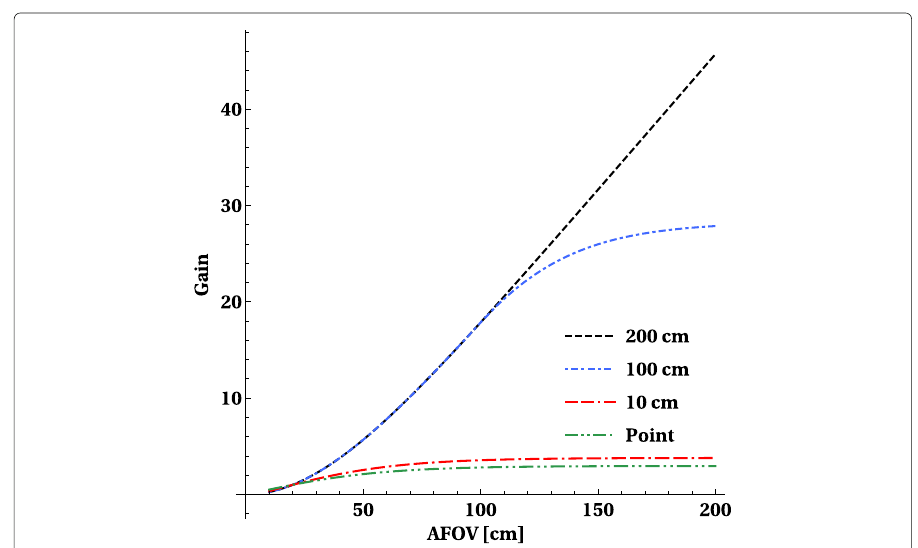
Fig. 10 The increase in sensitivity as a function of axial length for a point source, short object 10 cm, a 100-cm-long phantom and a 200-cm–long phantom all filled with activity. The y -axis displays the relative gain versus a system with 2-cm axial FOV